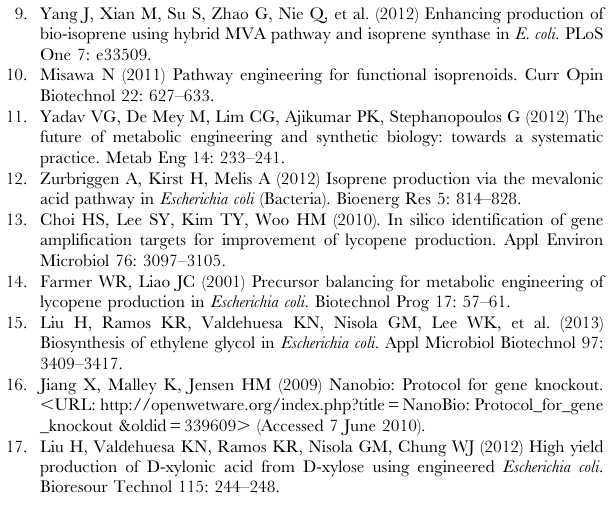
Figure S1 Optimization of MEP for improved isoprene production. A 160 mL serum bottle containing 40 mL of semi- defined medium, consisted of M9 salts, 5 g L 2 1 yeast extract, 10 g L 2 1 Glucose and 1 mM thiamine pyrophosphate (TPP), was utilized for the cultivation of the strains for isoprene production. Data were average values of duplicate cultivation runs. Gene symbol denotes the over-expressed gene in E. coli BW25113 (DE3). As the control, E. coli BW25113 (DE3) host (without isoprene synthase gene ispS) was also cultivated wherein no isoprene production was detected. Figure S2 GC analysis of isoprene production from strain FMIS 1. A 160 mL serum bottle containing 40 mL of semi-defined medium, consisted of M9 salts, 5 g L 2 1 yeast extract, 10 g L 2 1 Glucose and 1 mM thiamine pyrophosphate (TPP), was utilized for the cultivation of the strain FMIS 1 ( E. coli BW25113 (DE3)/ pACYC-dxs-ispG-idi-ispS ) for isoprene production. Table S1 Plasmids and strains used in this work. Table S2 Primers used in this study a . a Straight underline denotes restriction site, waved underline denotes ribosome